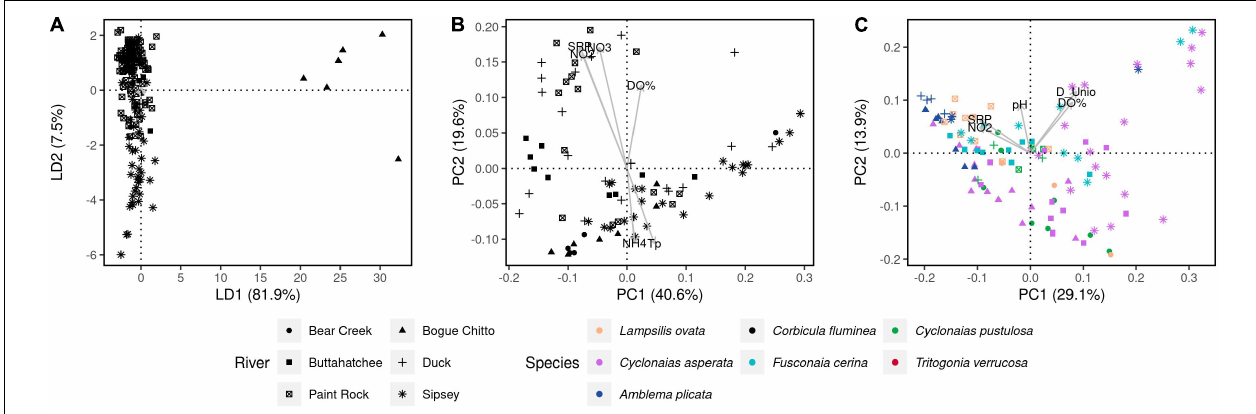
FIGURE 4 | Genetic and microbial dissimilarities in the invasive clam C. fluminea and six native freshwater mussel species, collected from six rivers in the Tennessee and Mobile River Basins. (A) DAPC showing the genetic dissimilarities between all 173 C. fluminea specimens that were included in the population genomics analysis (RADSeq). (B) PCoA displaying W-Unifrac dissimilarities between the gut microbiomes of the 80 individuals analyzed for their microbiome. (C) PCoA displaying W-Unifrac dissimilarities between the gut microbiomes of the native freshwater mussels collected. On plots (B,C) , Physicochemical and biological variables were correlated to the coordinates of each individual microbiome and are represented by arrows. Only parameters showing a significant correlation ( P < 0.05) are shown. D_Unio: unionid density; D_Corb: C. fluminea density; S: unionid richness; NO2: water nitrite; NO3: water nitrate; SRP: soluble reactive phosphorus in water; Tp: water